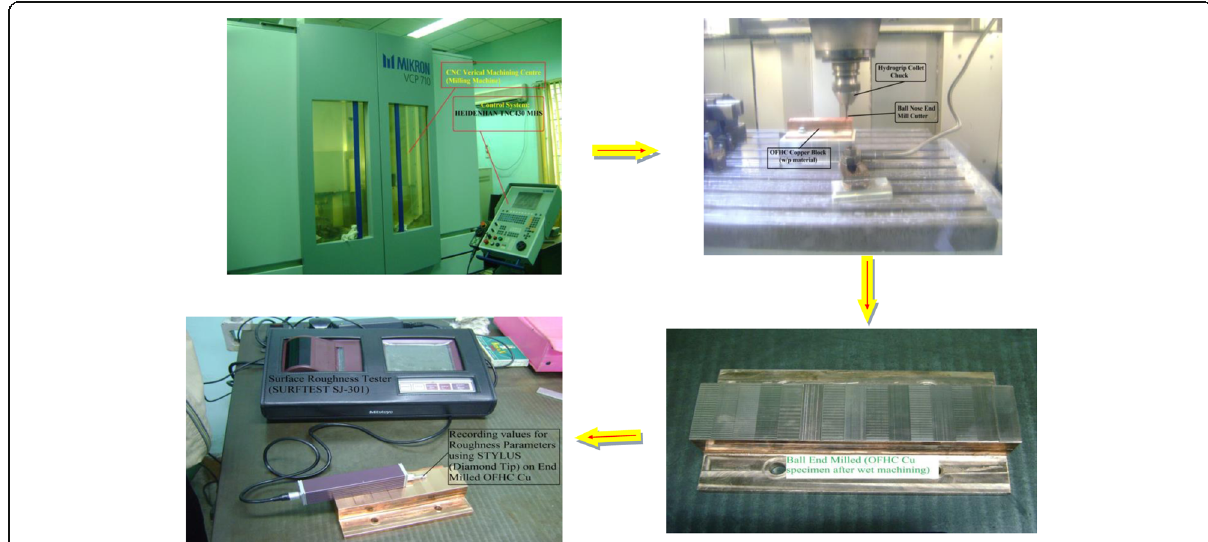
Fig. 1 Experimental setup for measurement of surface roughness using Mitutoyo Surftest SJ-301